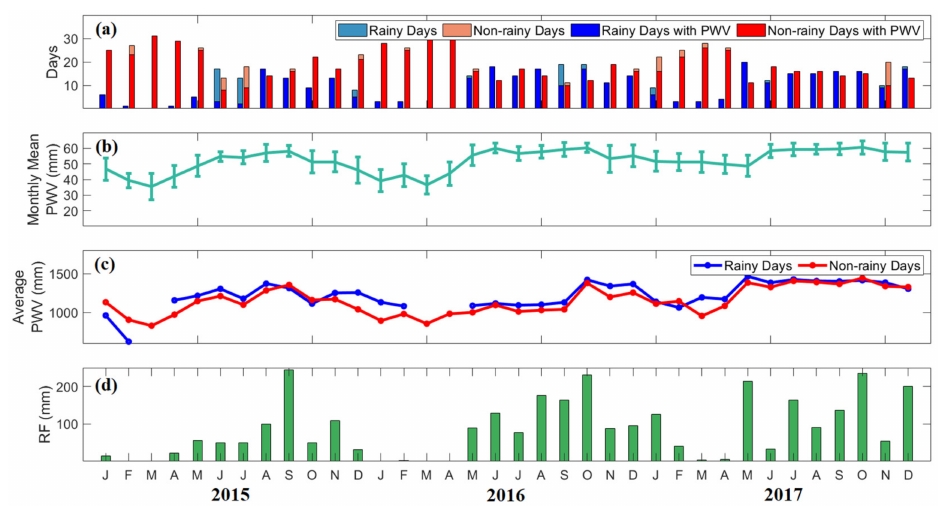
Figure 8. ( a ) The number of rainy and non-rainy days, and rainy and non-rainy days with PWV per month in Legaspi from 2015 to 2017. ( b ) The monthly mean variations of PWV for all days, ( c ) monthly total PWV, ( d ) monthly average of daily PWV, and ( d ) monthly rainfall are also presented. The color scales are in Figure